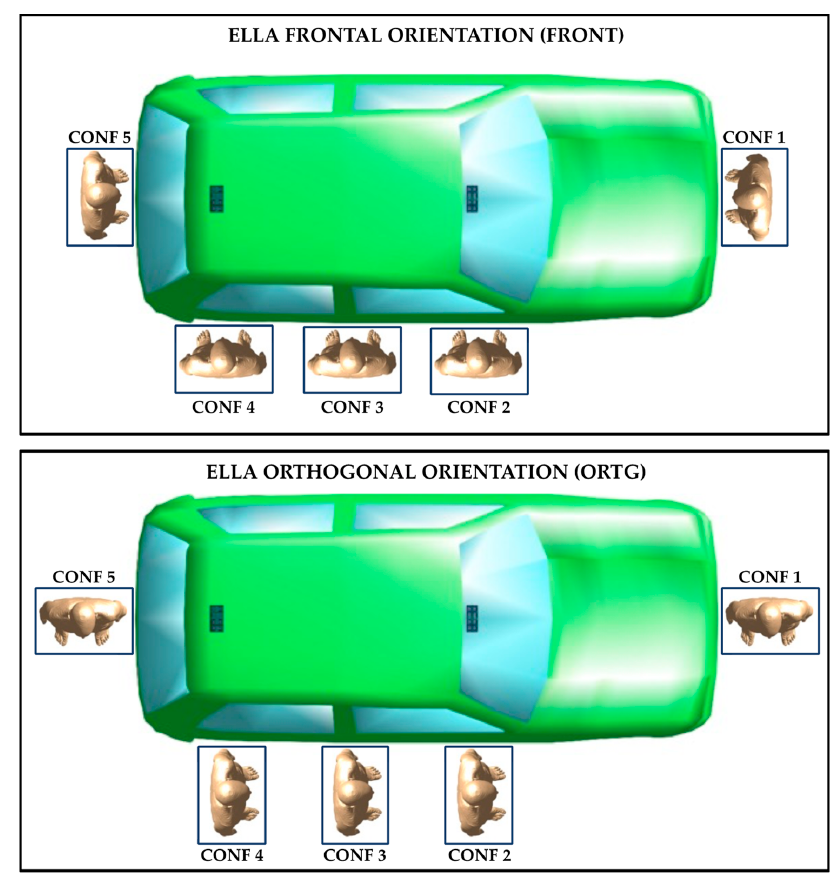
Figure 2. The exposure scenario with the car model, the phantom Ella at the five analyzed configurations and the two antenna arrays (the small dark rectangles at the front and rear of the car). The Ella model is placed in the ‘FRONT’ ( top panel) and ‘ORTG’ orientation ( bottom panel) with respect to the car body.